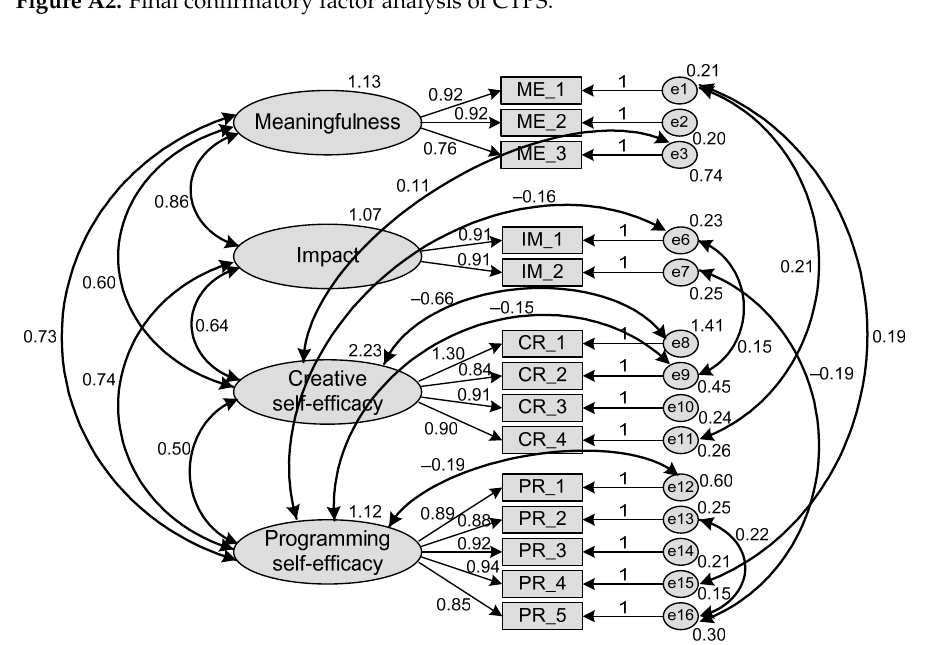
Figure A2. Final confirmatory factor analysis of CTPS.